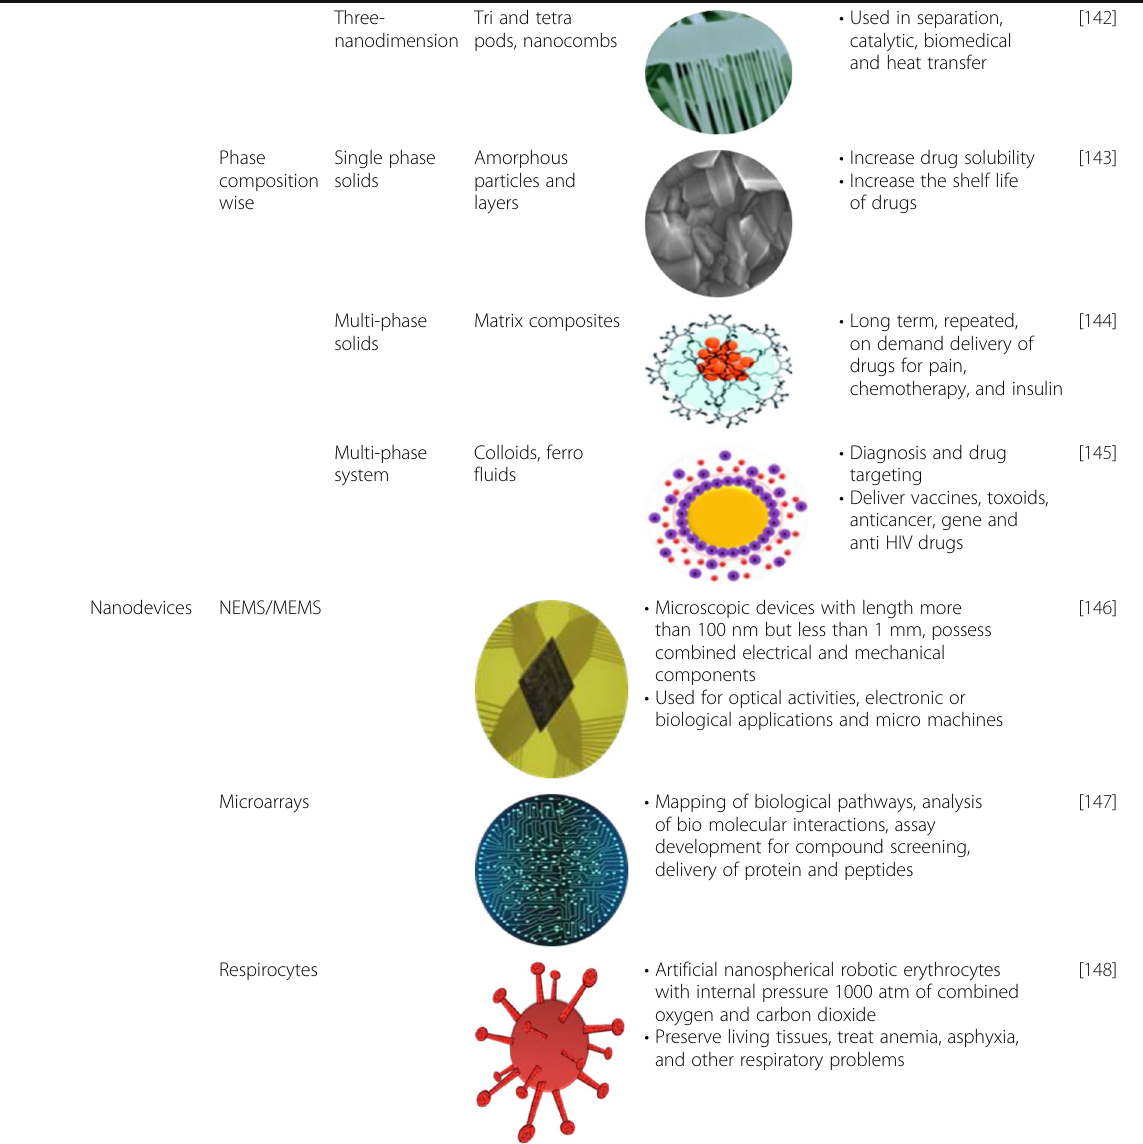
Table 1 Pharmaceutical nanosystems (classification of nanotools) (Continued)